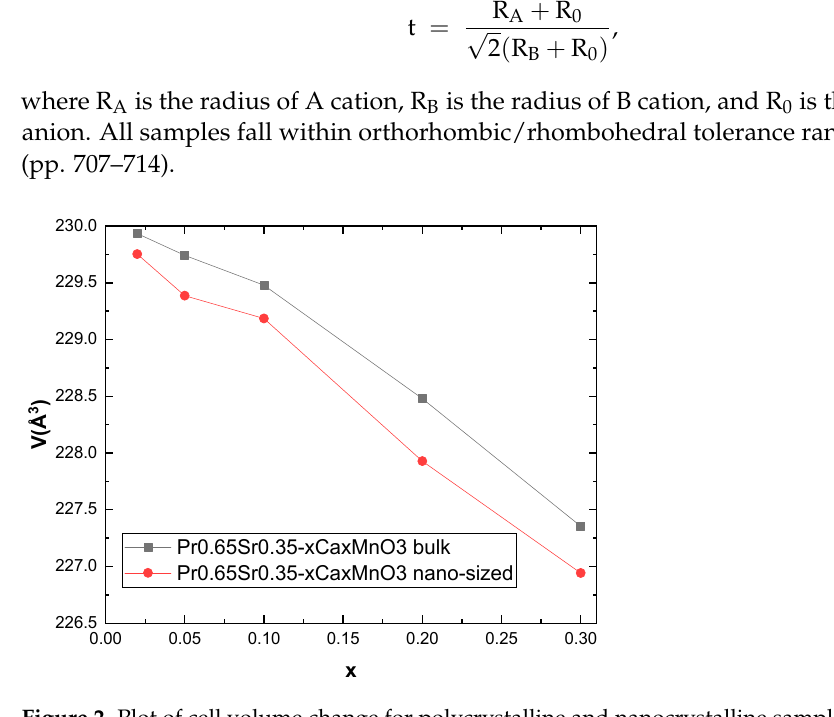
Table 2. Calculated Mn-O lengths and crystallite sizes for nanocrystalline samples using the Wil- liamson–Hall and Rietveld methods and including grain diameters from TEM. Ca Con- tent (Nano) Mn-O (Å) Mn-O-Mn